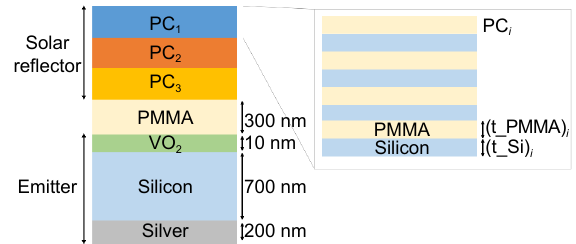
Fig. 2 | Design of the switchable radiative cooler. Emitter part consists of stacked layers of silver, silicon and VO 2 . Solar reflector part consists of three photonic crystals that have 4 pairs of PMMA and silicon. PC i is designed to suppress absorption at λ i where λ 1 = 0.52 μm, λ 2 = 0.76 μm and λ 3 = 1.18 μm. Thickness of each layer is λ i /4 n .